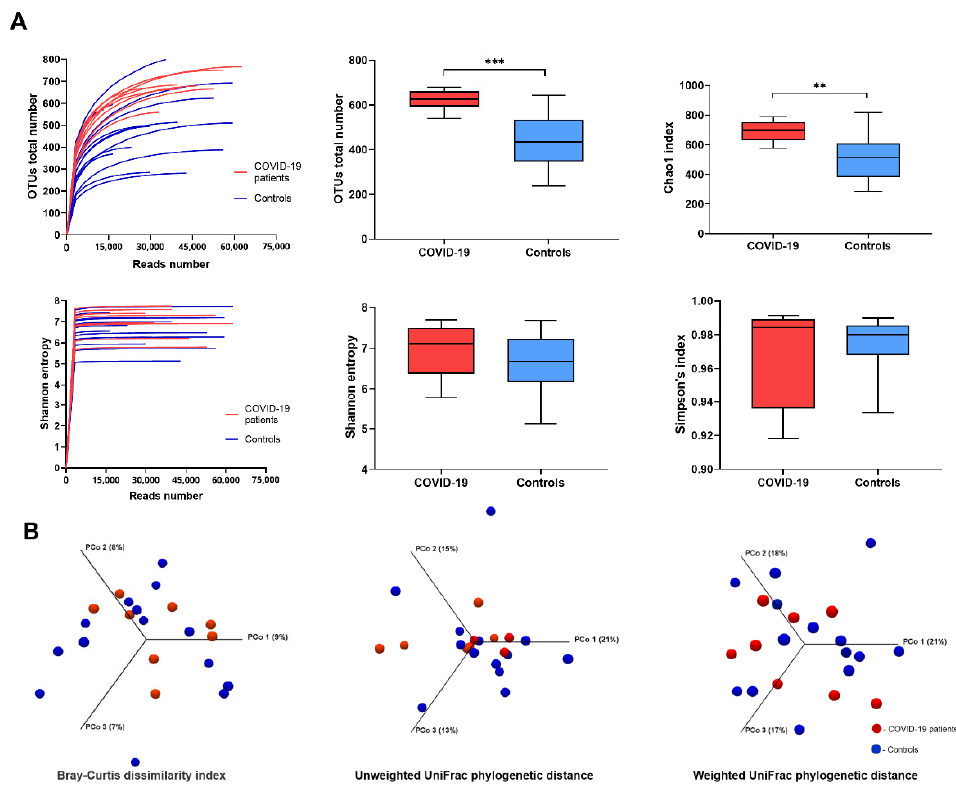
Figure 1. Alpha and beta diversity of the gut microbiota between COVID-19 patients and healthy controls. ( A ) Richness with operational taxonomic units (OTUs) number and within-sample diversity calculated with the Chao1, Shannon entropy, and Simpson index (median, quartile Q1–Q3, min–max). Asterisks denote statistically significant differences given by the Mann–Whitney test (** p < 0.01, *** p < 0.001) ( B ). Comparison between sample diversities by principal coordinates analysis (PCoA) with a Bray–Curtis dissimilarity matrix and with unweighted and weighted Unifrac distance. Red and blue represent COVID-19 patients and healthy control data, respectively.